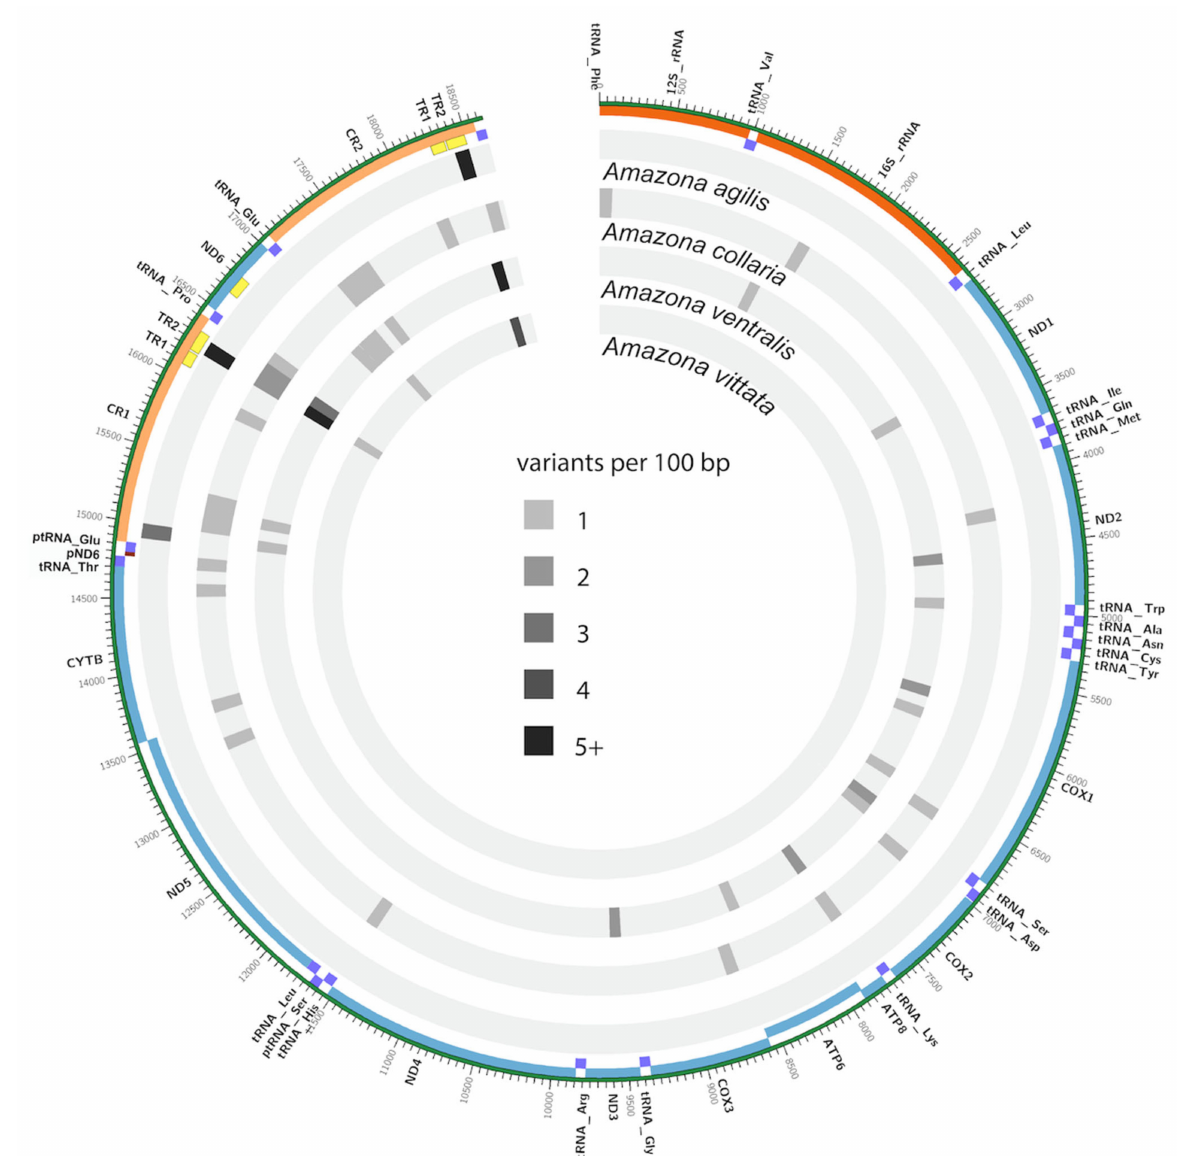
Figure 4. Circos plot showing intraspecific variation in four species of Amazona parrots from the Greater Antilles. Despite having the most individual sequences, A. vittata shows very little variation compared to other parrot species. Each track shows the density of variation (variants per 100 bp) between all the individuals sequenced from a single species. A. vittata n = 10; A. ventralis n = 2; A. agilis n = 2; A. collaria n = 7. The figure was generated using Circos [27]. Files containing locations of all polymorphisms are presented in Appendix C. Absolute character differences within four species of Greater Antillean are given in Supplementary Table S9. Visualizations of the alignments can be found in Supplementary Figure